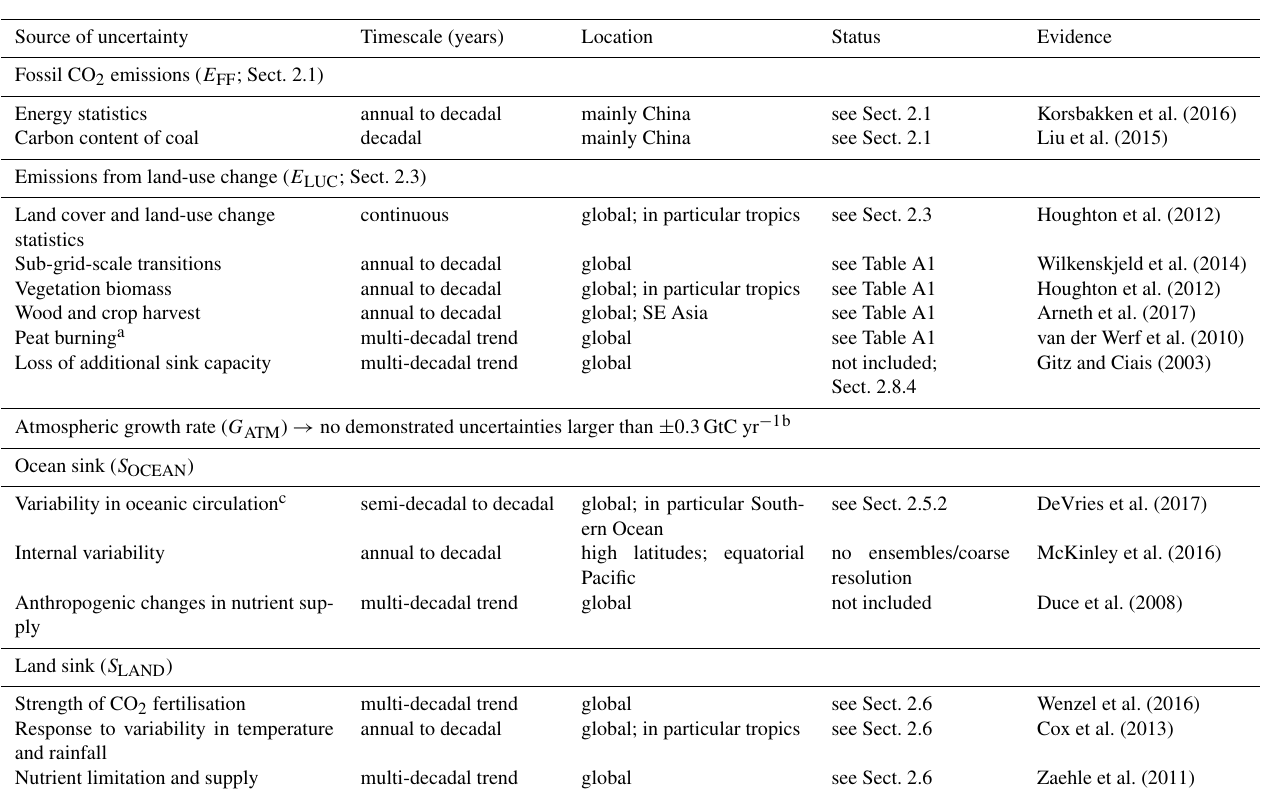
Table 9. Major known sources of uncertainties in each component of the global carbon budget, defined as input data or processes that have a demonstrated effect of at least ± 0 . 3GtCyr − 1